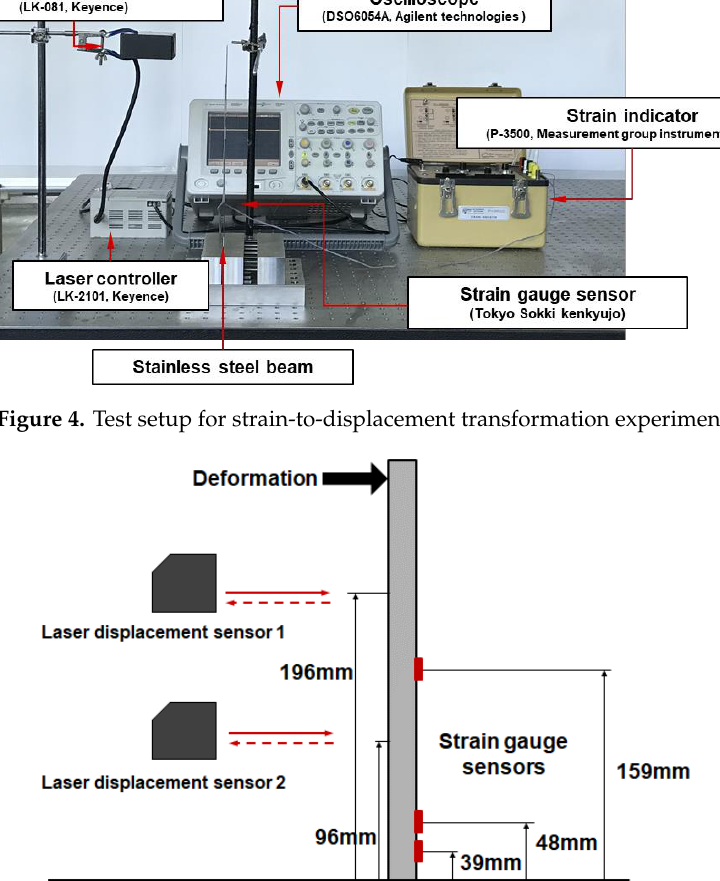
Figure 5. Measurement points of the stainless steel beam.